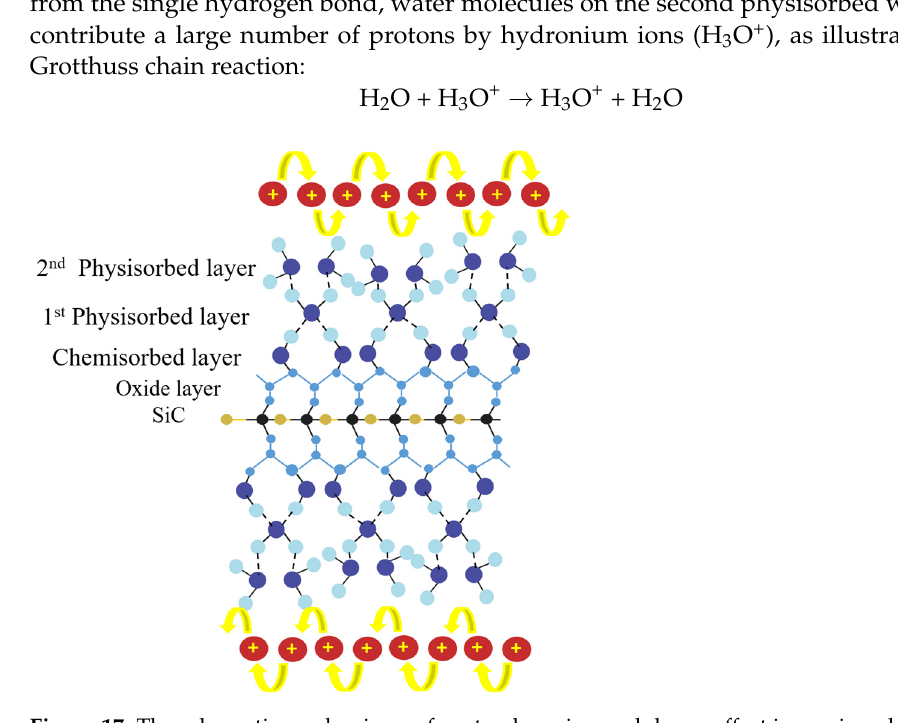
Figure 17. The schematic mechanisms of proton hopping and donor effect in semiconductor-based humidity sensor.